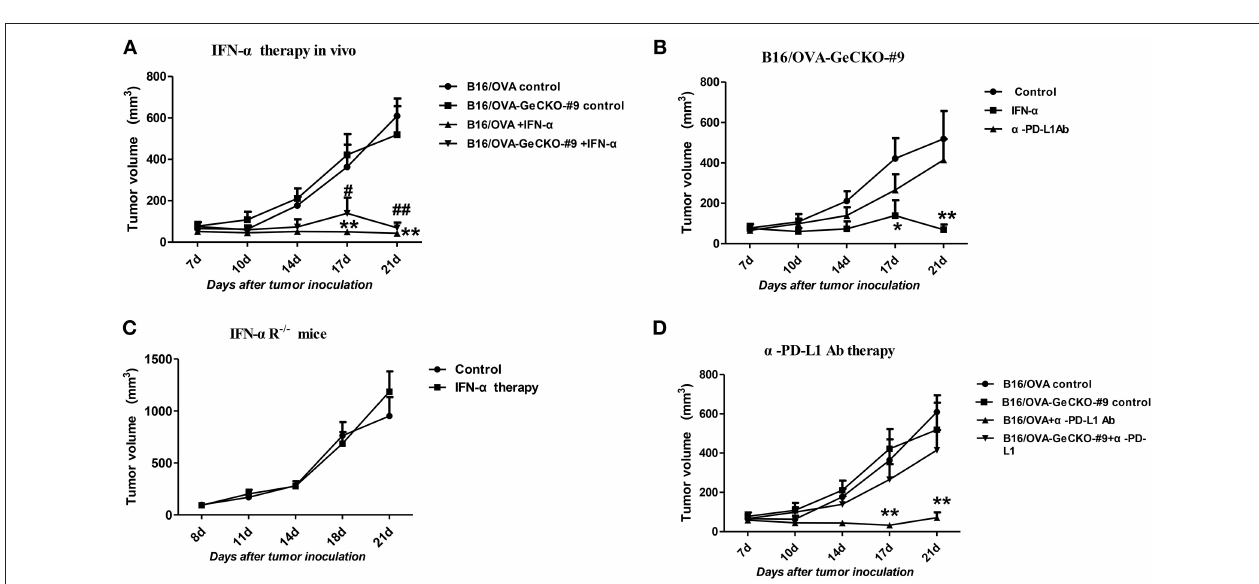
FIGURE 6 | JAK–STAT signaling is differentially activated in tumor and non-tumor cells in response to various immunotherapies. (A–D) Wild-type (WT) B6 or IFNAR1 − / − mice ( n = 5/group) were subcutaneously injected with 5 × 10 5 B16/OVA cells and their derivatives; starting 8 days later, tumors were injected with 5 µ g IFN- α (A–C) or 25 µ g anti-PD-L1 antibody (D) or control antibody twice a week. Tumor volume was also measured twice a week. Data are presented as the mean ± SEM. * P < 0.05 vs. B16-OVA GeCKO-#9 control group; ** P < 0.01 vs. B16-OVA GeCKO-#9 control group (B) ; ** P < 0.01 vs. B16-OVA control group; # P < 0.05 vs. B16/OVA-GeCKO-#9 control group; ## P < 0.01 vs. B16/OVA-GeCKO-#9 control group; (A,D) .